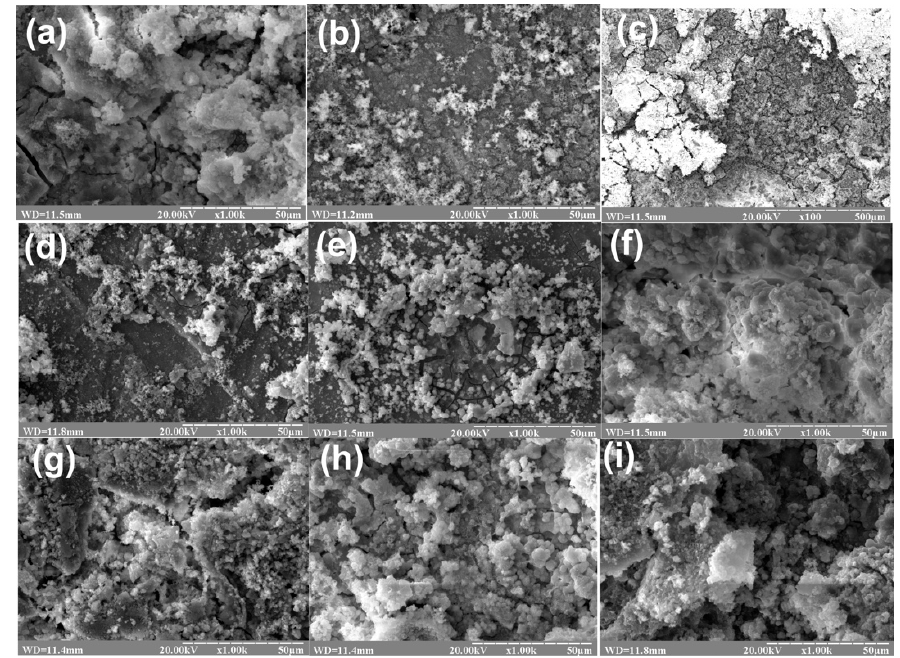
Figure 2. SEM images of surface morphology of HA coatings on Mg substrates deposited under